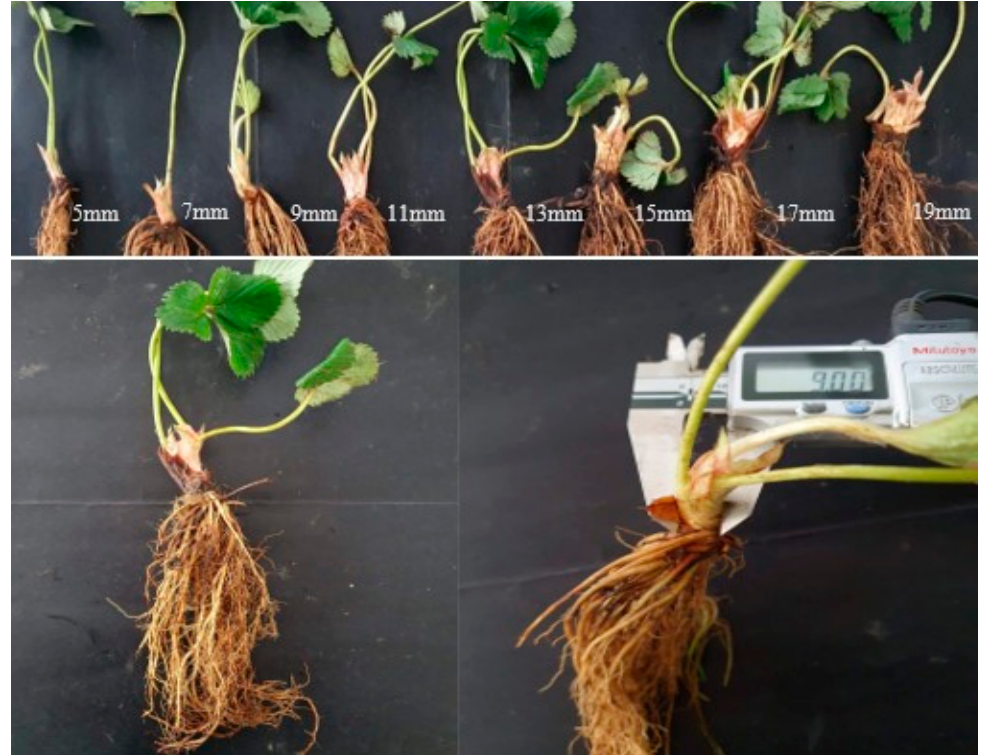
Figure 1. Strawberry plants of the type “bare-root fresh plants” from the cultivar Pircinque, classified according to different crown diameters.